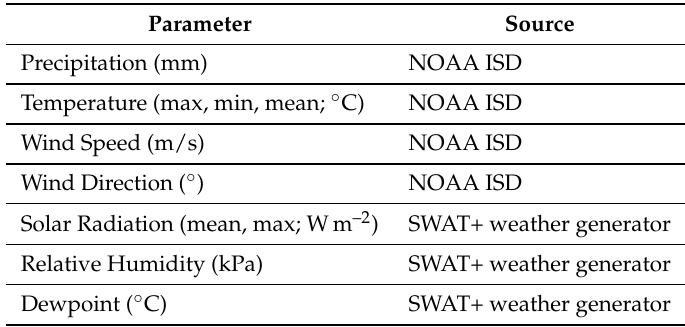
Table 2. Weather-parameter feature vectors for the LSTM and their sources. Missing values from NOAA data were filled in using long-term monthly means and the SWAT+ weather generator.